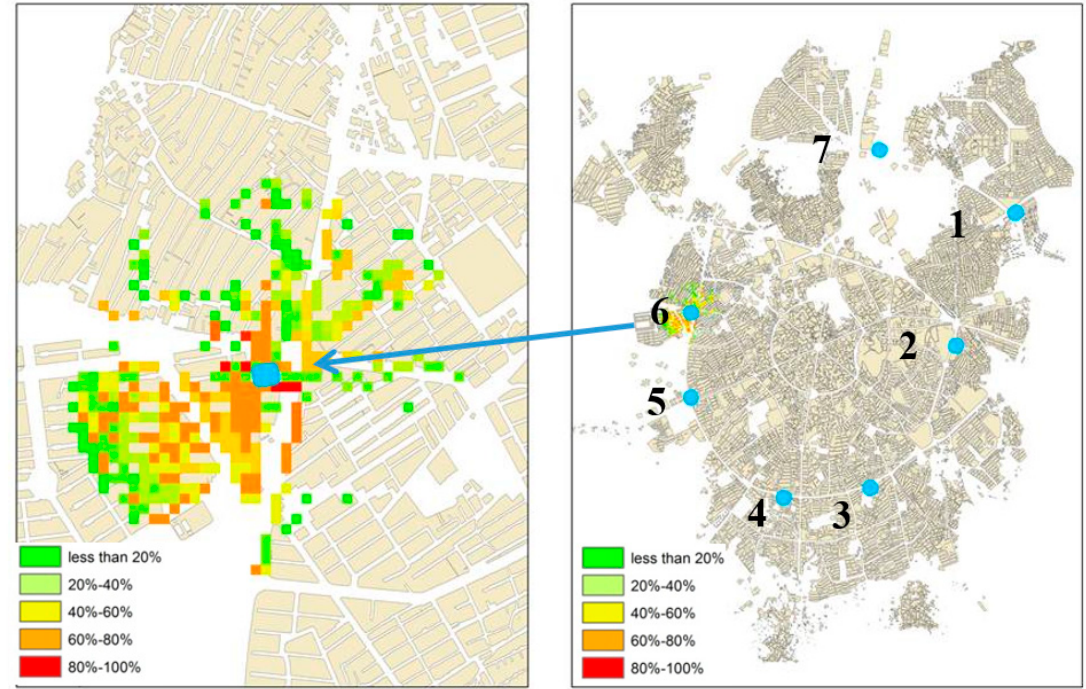
Figure 27. Visibility map of hypothetical tall building No. 6.